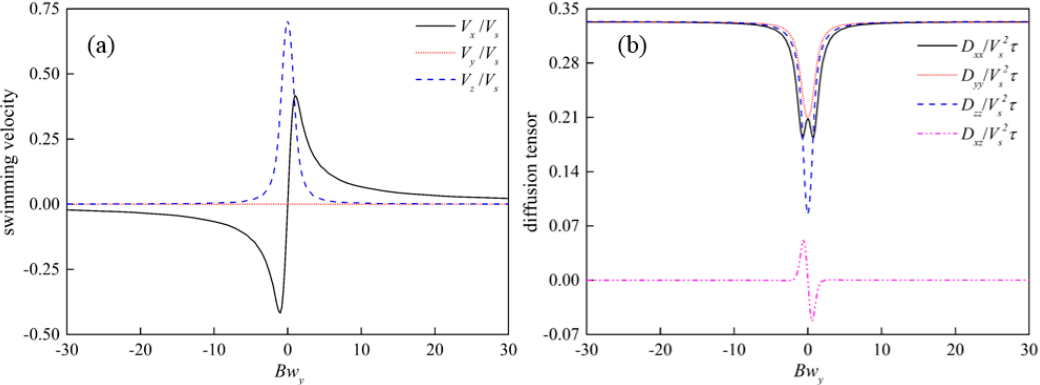
Figure 17. Variation of swimming velocity ( a ) and translational diffusivity tensor ( b ) with w y .